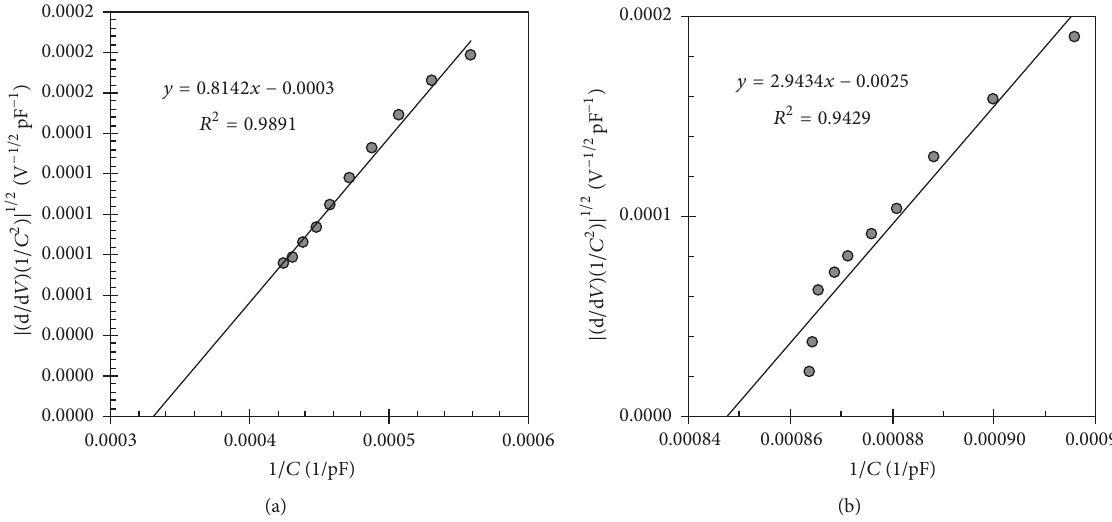
Figure 18: d (1/𝐶 2 )/ d 𝑉 versus 1/𝐶 plot for 500 kHz for 𝐶